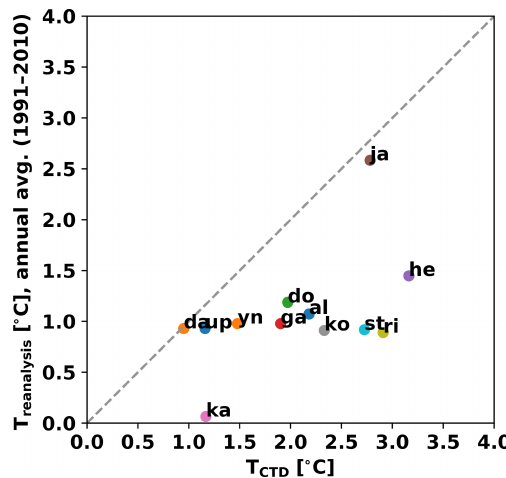
Figure 4. Temperature at the grounding line depth of CTD mea- surements closest to glacier front, inside the fjords ( x axis) and temperatures reconstructed from reanalysis data ( y axis) from the nearest possible grid cell for all 12 glaciers: Alison (al), Daugaard- Jensen (da), Docker Smith (do), Gade (ga), Helheim (he), Jakob- shavn Isbrae (ji), Kangerlussuaq (ka), King Oscar (ko), Rink Isbrae (ri), Store (st), Upernavik Isstrom N (up), Yngvar Nielsen (yn).